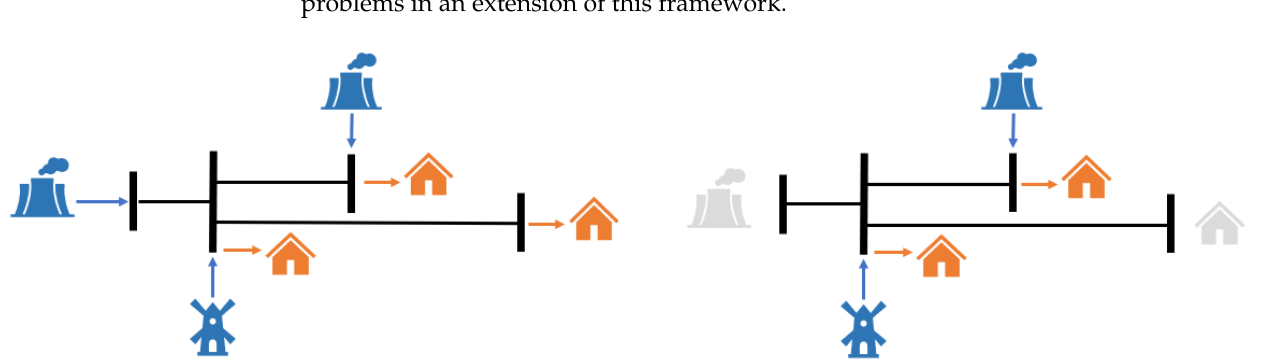
Figure 6. Simplified load-shedding